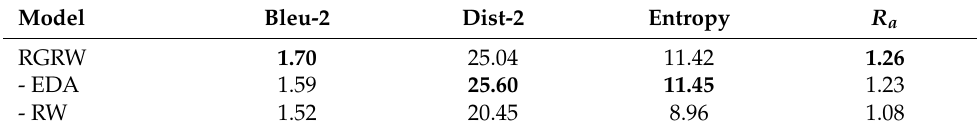
Table 5. Ablation study on two attention layers. Scores in bold are the highest score for each metric. Model Bleu-2 Dist-2 Entropy R a